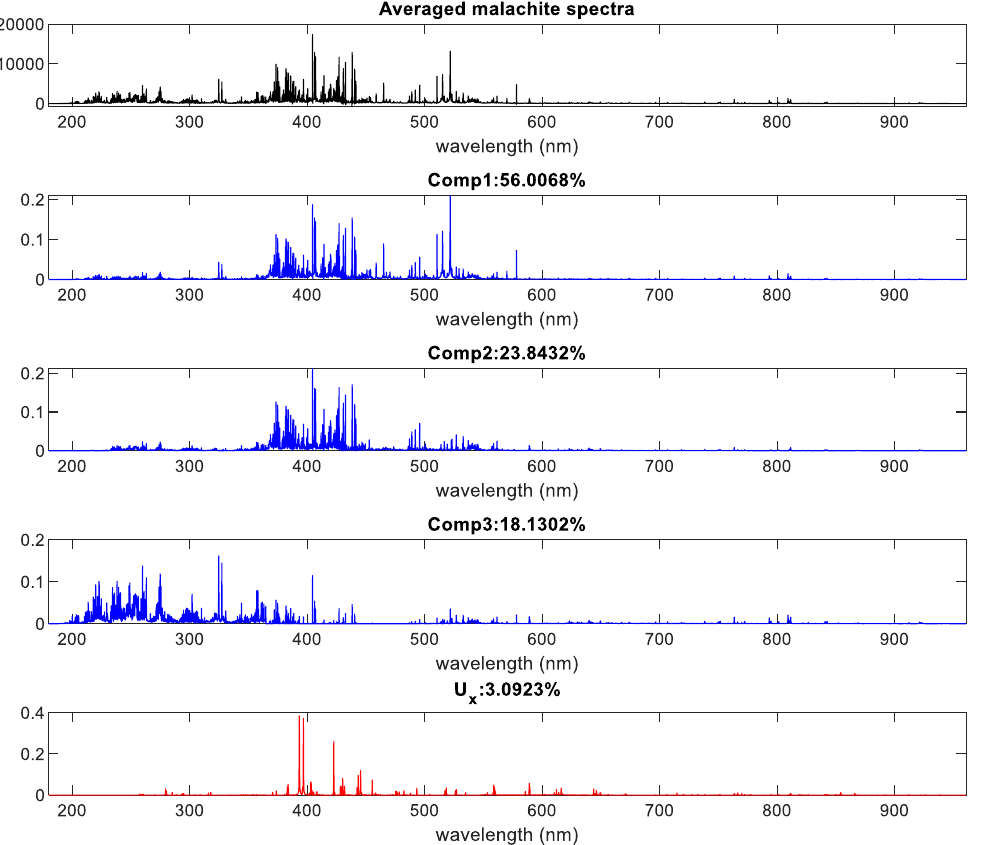
Figure5. Exampleoflatentspectraextraction. Figure 5. Example of latent spectra extraction. The averaged spectrum originates from all malachite MPs.